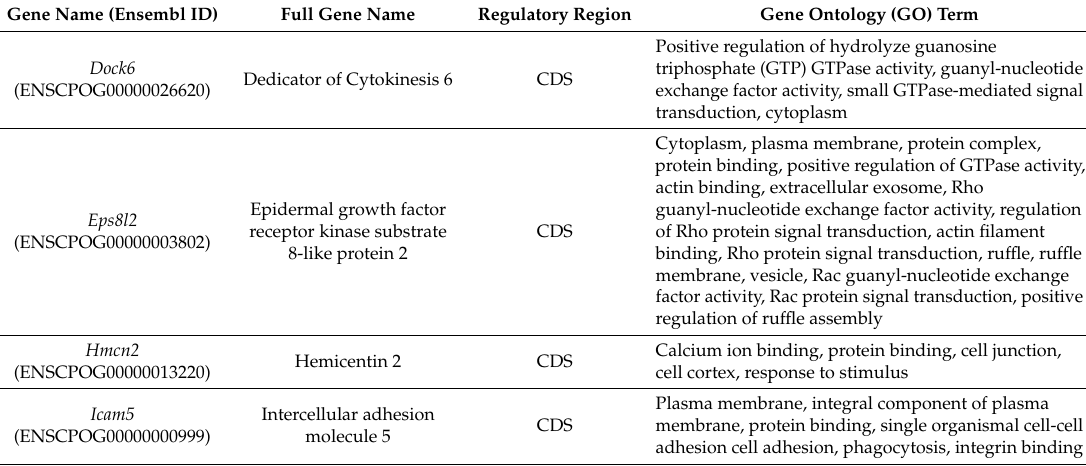
Figure 5. Venn diagram of genes with DMRs after both environmental factors. Of the 155 genes with DMRs identified in the livers of sons sired after a paternal protein diet and the 98 genes with DMRs identified after paternal heat exposure, 21 DMRs were shared between both experiments (diet and heat). Of those, three DMRs were overlapping promoter regions, and 18 DMRs were overlapping CDSes (listed in Table 1). Table 1. Twenty-one genes with DMRs shared in all five father-sorted son groups of the “nutrition” and “heat”